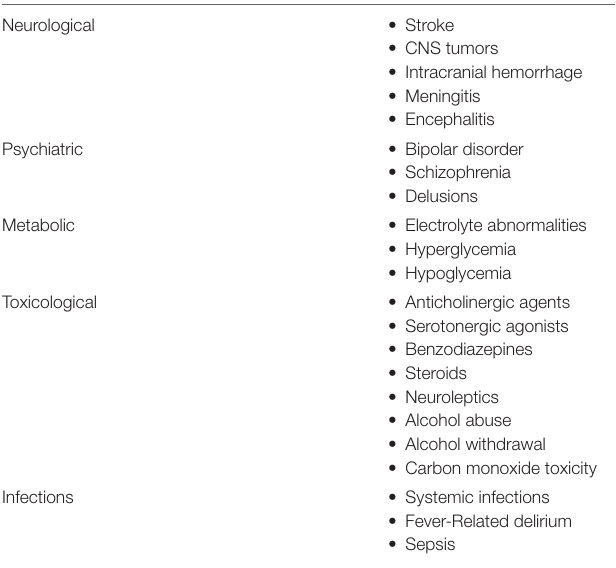
TABLE 1 | Differential diagnoses in case of dementia-related agitation and other conditions.